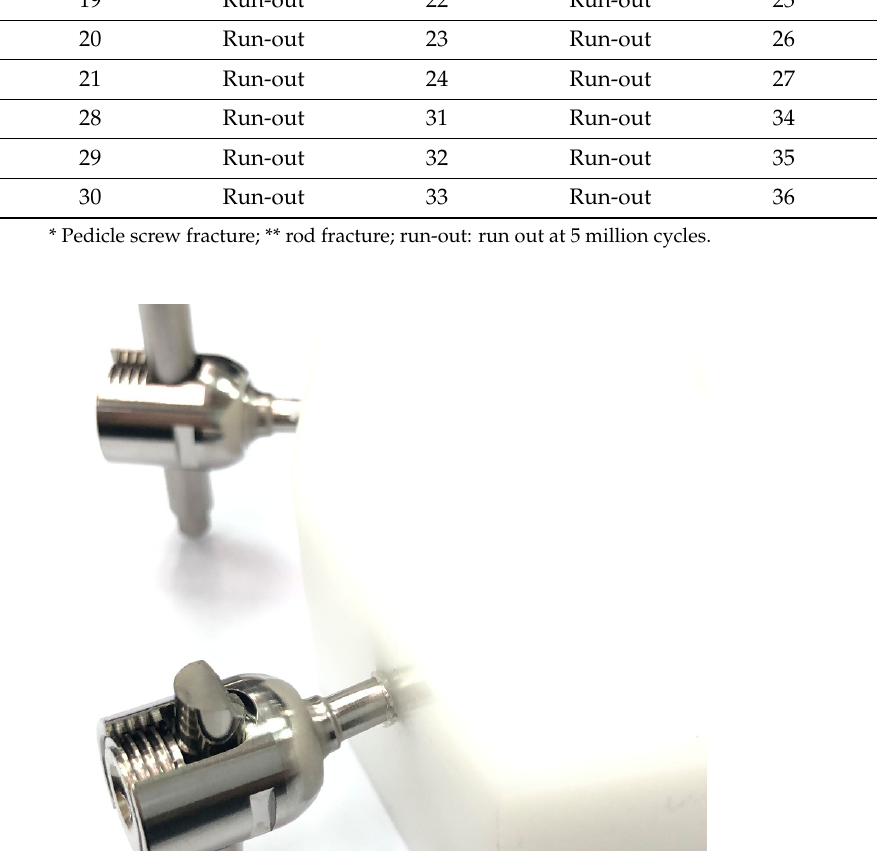
Figure 3. Rod failed in the proximally unthreaded (PU) groups in the dynamic compression bend- ing test.